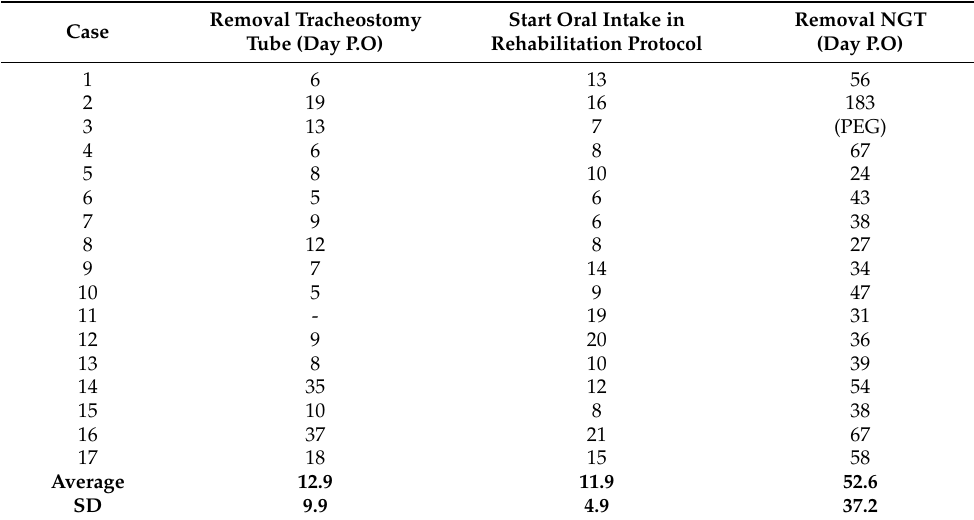
Table 2. Respiration and deglutition outcomes in enrolled